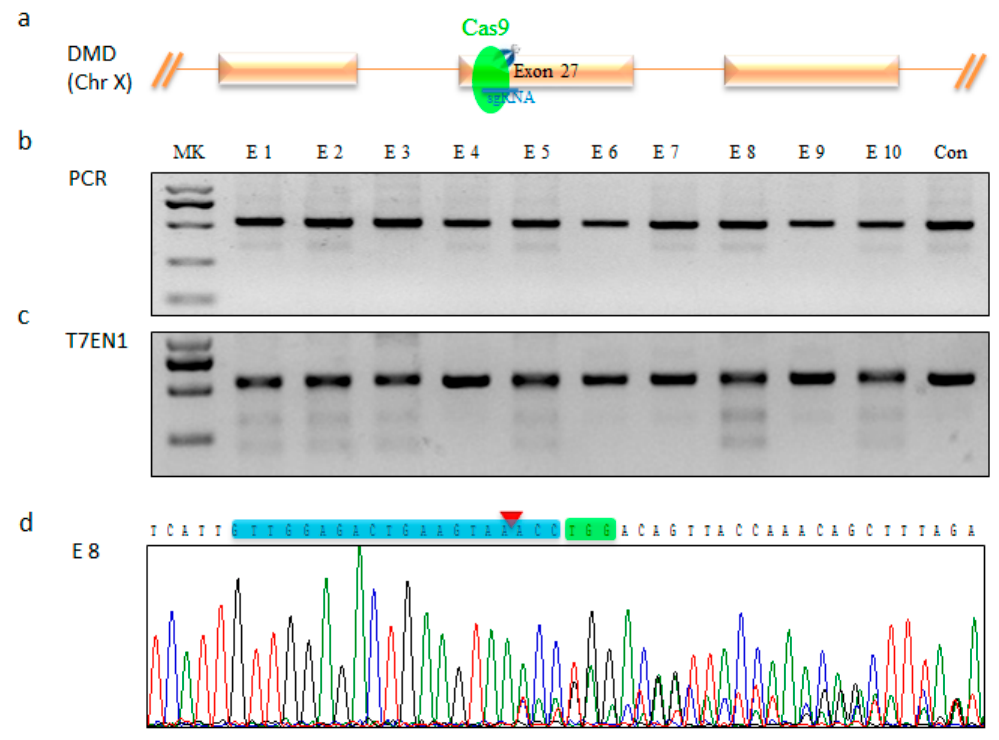
Figure 1. Evaluation of DMD sgRNA:Cas9-mediated modifications of DMD in pig parthenogenetic embryos. ( a ) Schematic diagram of the pig DMD partial protein coding region and the DMD sgRNA:Cas9 targeting site; ( b ) Polymerase chain reaction (PCR) products of the DMD targeting region in pig embryos. MK, DNA marker; Con, PCR product of the targeted region amplified from wild-type pig; ( c ) Detection of sgRNA:Cas9-mediated on-target cleavage of DMD by T7EN1 cleavage assay in pig embryos; ( d ) Representative sequencing chromatographs of PCR product. Blue background indicates the DMD sgRNA sequence. Red triangle indicates cleavage site mediated by DMD sgRNA:Cas9. Green background indicates PAM construct.